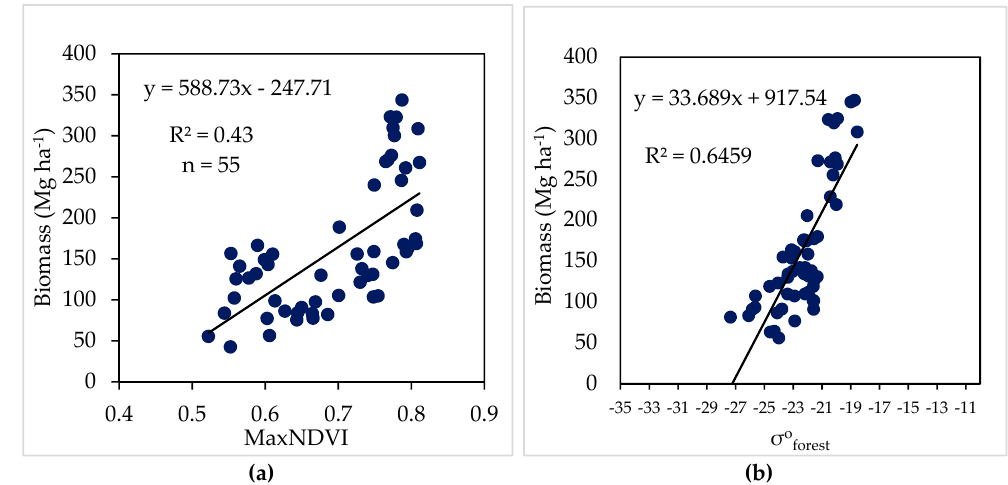
Figure 3. ( a ) The relationship between biomass and max NDVI value; ( b ) the relationship between biomass and σ ° forest value.